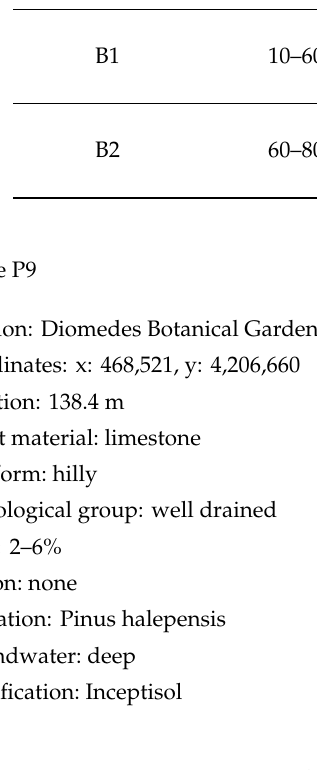
Table A17. Profile P9 horizons